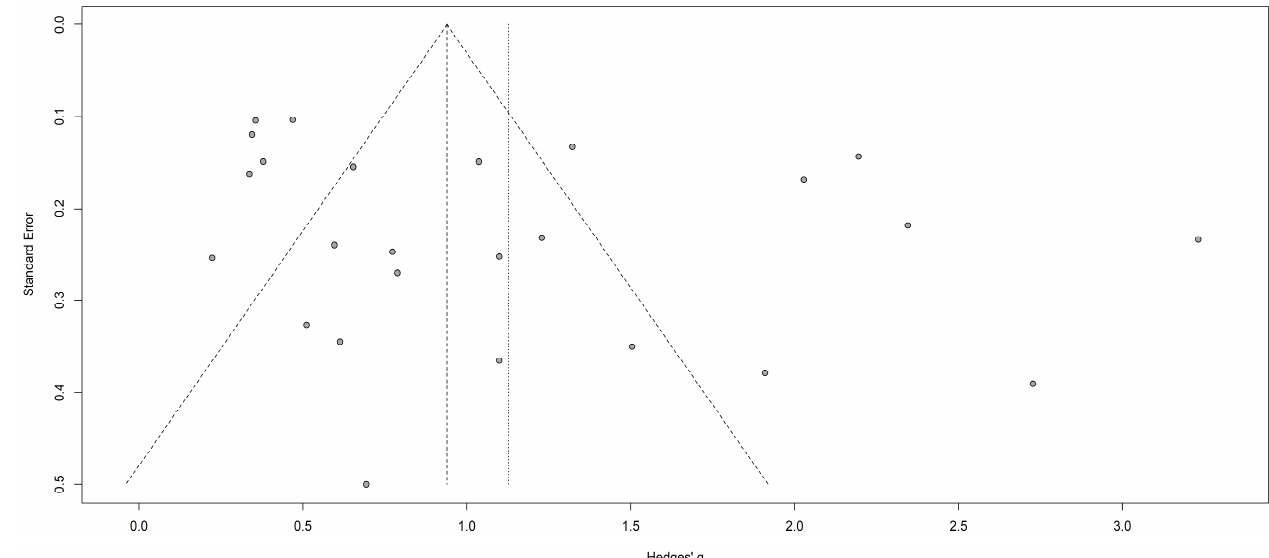
Figure 3. Funnel plot of the meta-analysis on the clinical cure rate of treatments for bacterial vaginosis. An Egger test was used to detect asymmetry in the funnel plot that could suggest the presence of publication bias ( p = 0.1097).